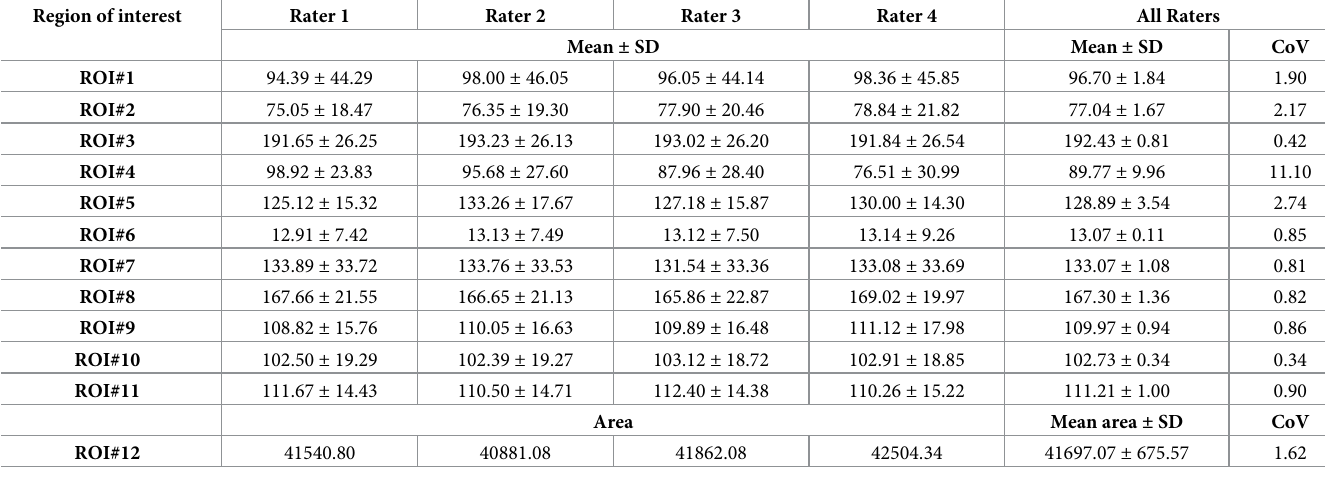
Table 1. Mean results, standard deviation and coefficient of variation of the reflectivity of ROIs#1–11 and area of ROI#12 of different raters. Region of interest